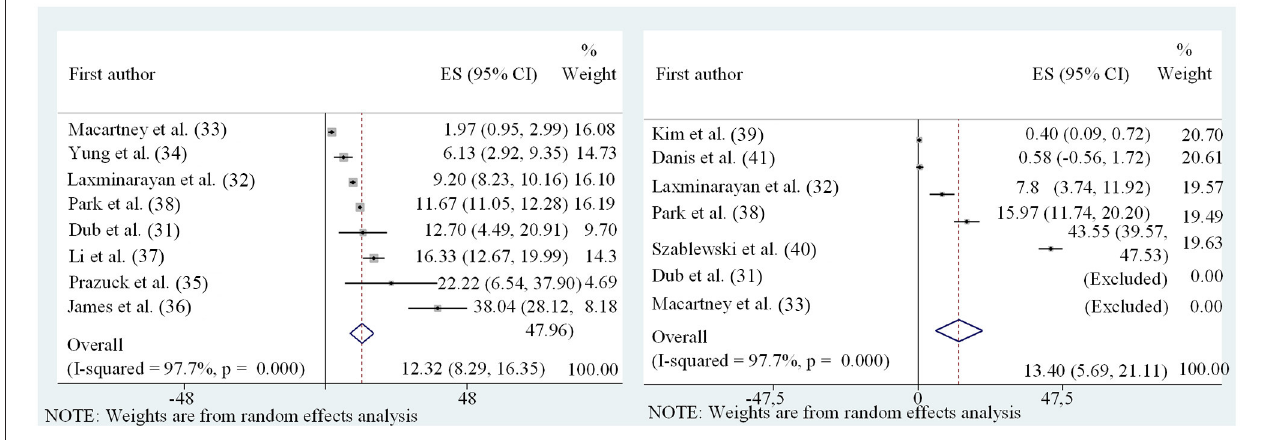
FIGURE 7 | Forest plot of meta-analysis of secondary attack rates of child (Left) and adult (Right) index persons.